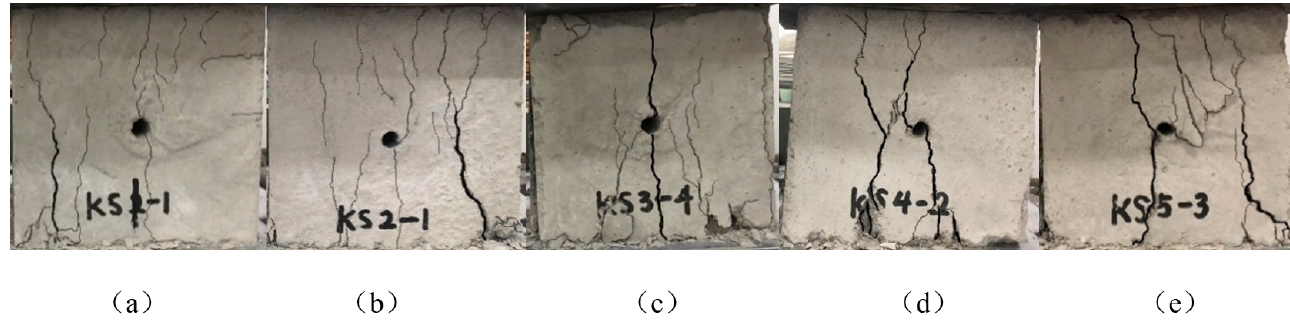
Figure 9. ( a ) is the drilling depth of a 3 cm sample failure diagram, ( b ) is the drilling depth of a 6 cm sample failure diagram, ( c ) is the drilling depth of a 9 cm sample failure diagram, ( d ) is the drilling depth of a 12 cm sample failure diagram, and ( e ) is the drilling depth of a 15 cm sample failure diagram.